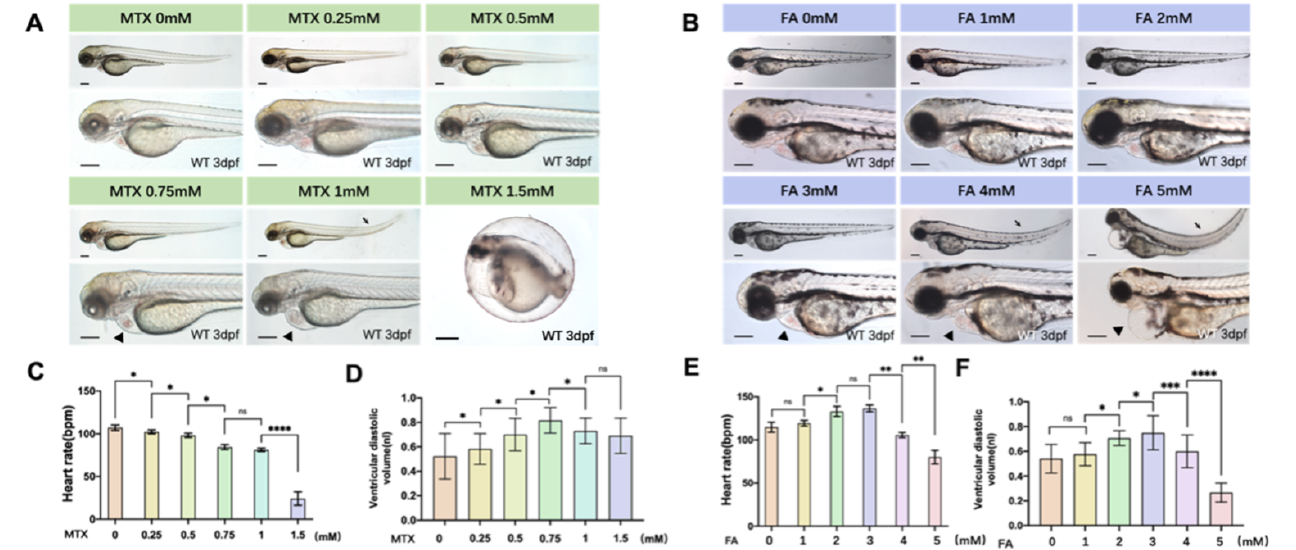
Figure 1. Zebrafish heart dysplasia caused by folic acid and folic acid inhibitors is dose-dependent. ( A ) The use of different concentrations of folic acid inhibitors can cause abnormal heart development in zebrafish embryos. The concentration of MTX1.5 mM will cause the zebrafish embryo to be deformed and unable to break the eggs. Arrowheads mark abnormal heart development. Arrows indicate trunk flexion. Scale bars: 500 µ m. ( B ) Excessive folic acid can also cause abnormal heart development in zebrafish embryos. Scale bars: 500 µ m. ( C ) The heart rate of zebrafish embryos treated with folic acid inhibitors was statistically analyzed. ( D ) The ventricular diastolic volume of zebrafish embryos treated with folic acid inhibitors was statistically analyzed. ( E ) The heart rate of zebrafish embryos treated with different concentrations of folic acid was analyzed statistically. ( F ) The ventricular diastolic volume of zebrafish embryos treated with different concentrations of folic acid was statistically analyzed. (Student t -test, * p < 0.05, ** p < 0.01, *** p < 0.001, **** p < 0.0001, ns: no statistical